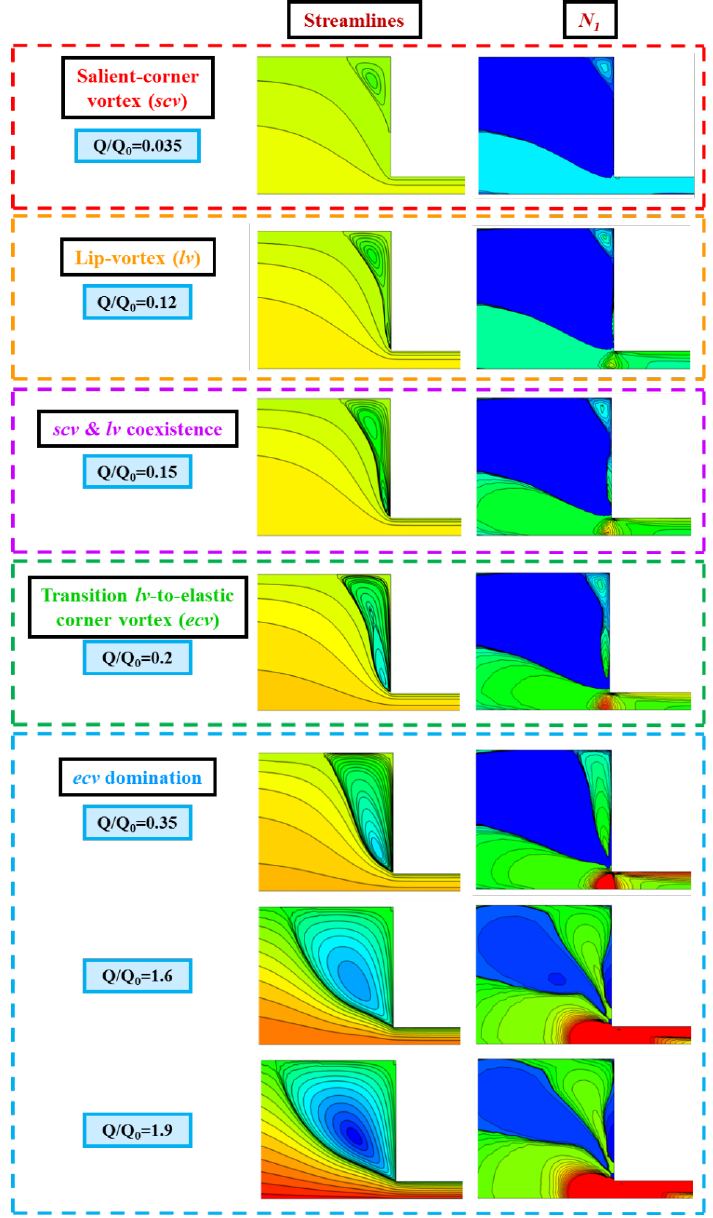
 = {0.075};  ≤ 0.9, L = 5. D